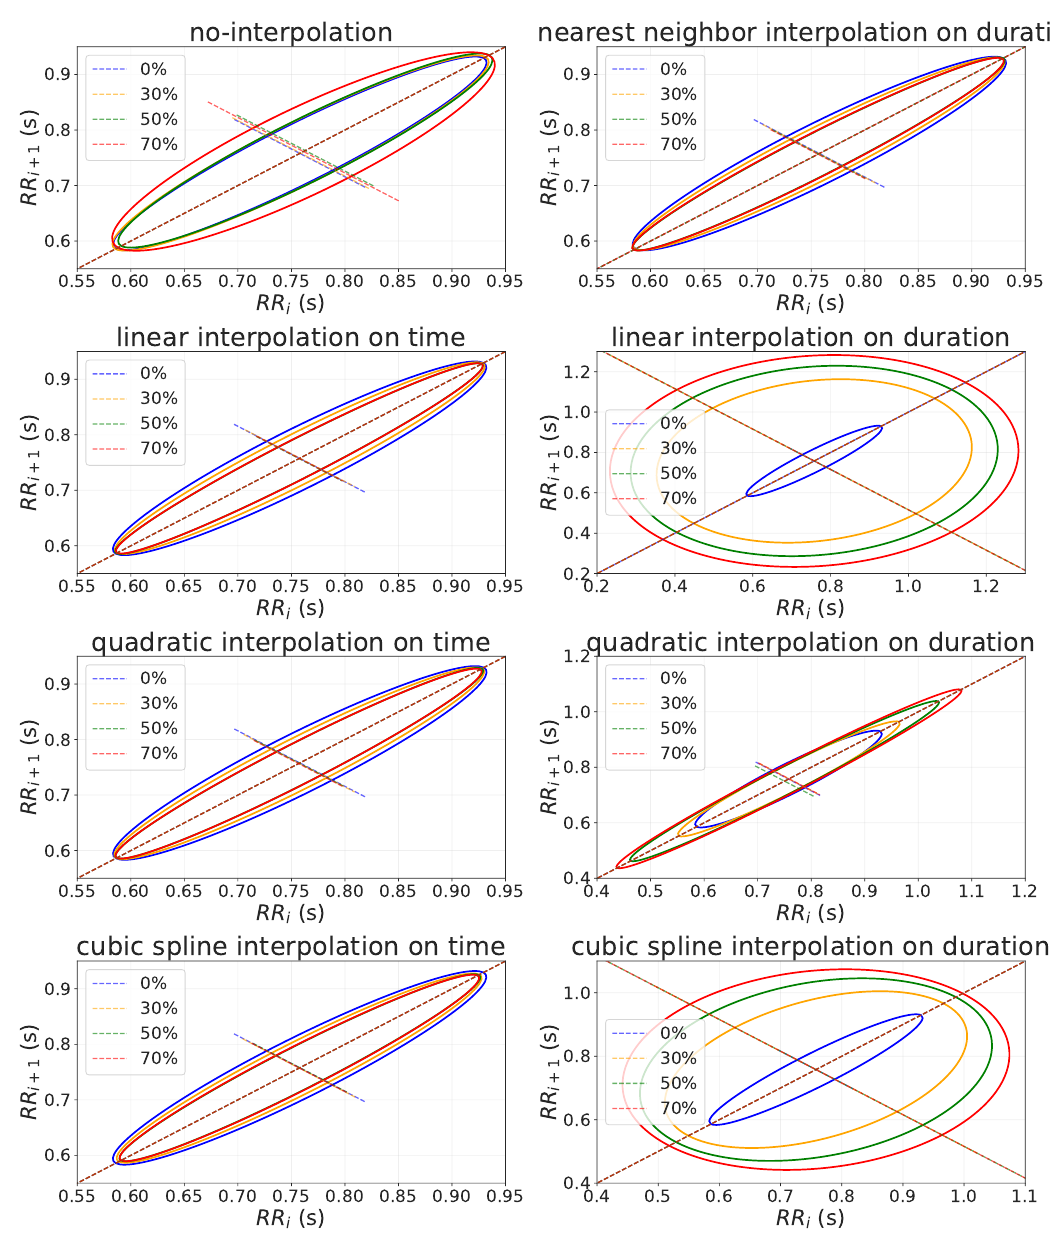
Figure 6. Poincaré plot of a user’s RR-intervals timeseries recorded in 5 min with different percentage of missing values (i.e., 0%, 30%, 50% and 70%) handled with different interpolation methods (i.e., nearest neighbor, linear, quadratic and cubic spline) on both time and